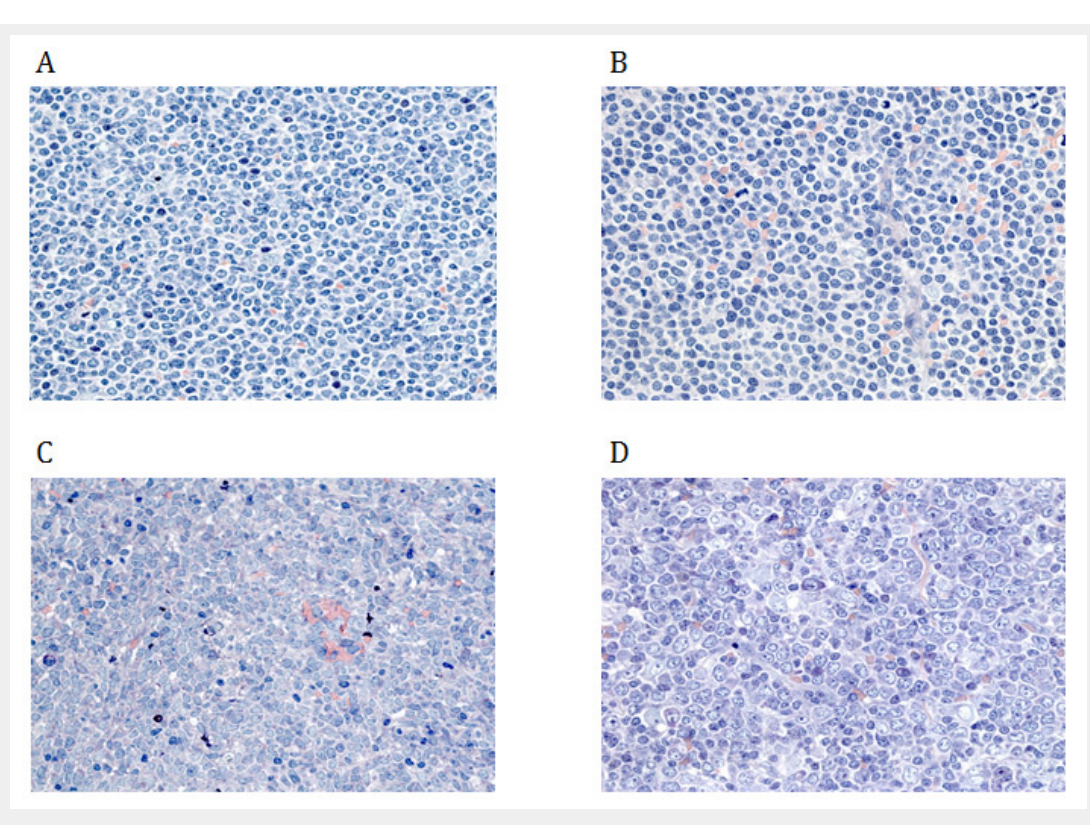
Figure 1 Cytomorphologic subtypes of mantle cell lymphoma: (A) classical, (B) small cell variant, (C) blastoid variant, (D) pleomorphic